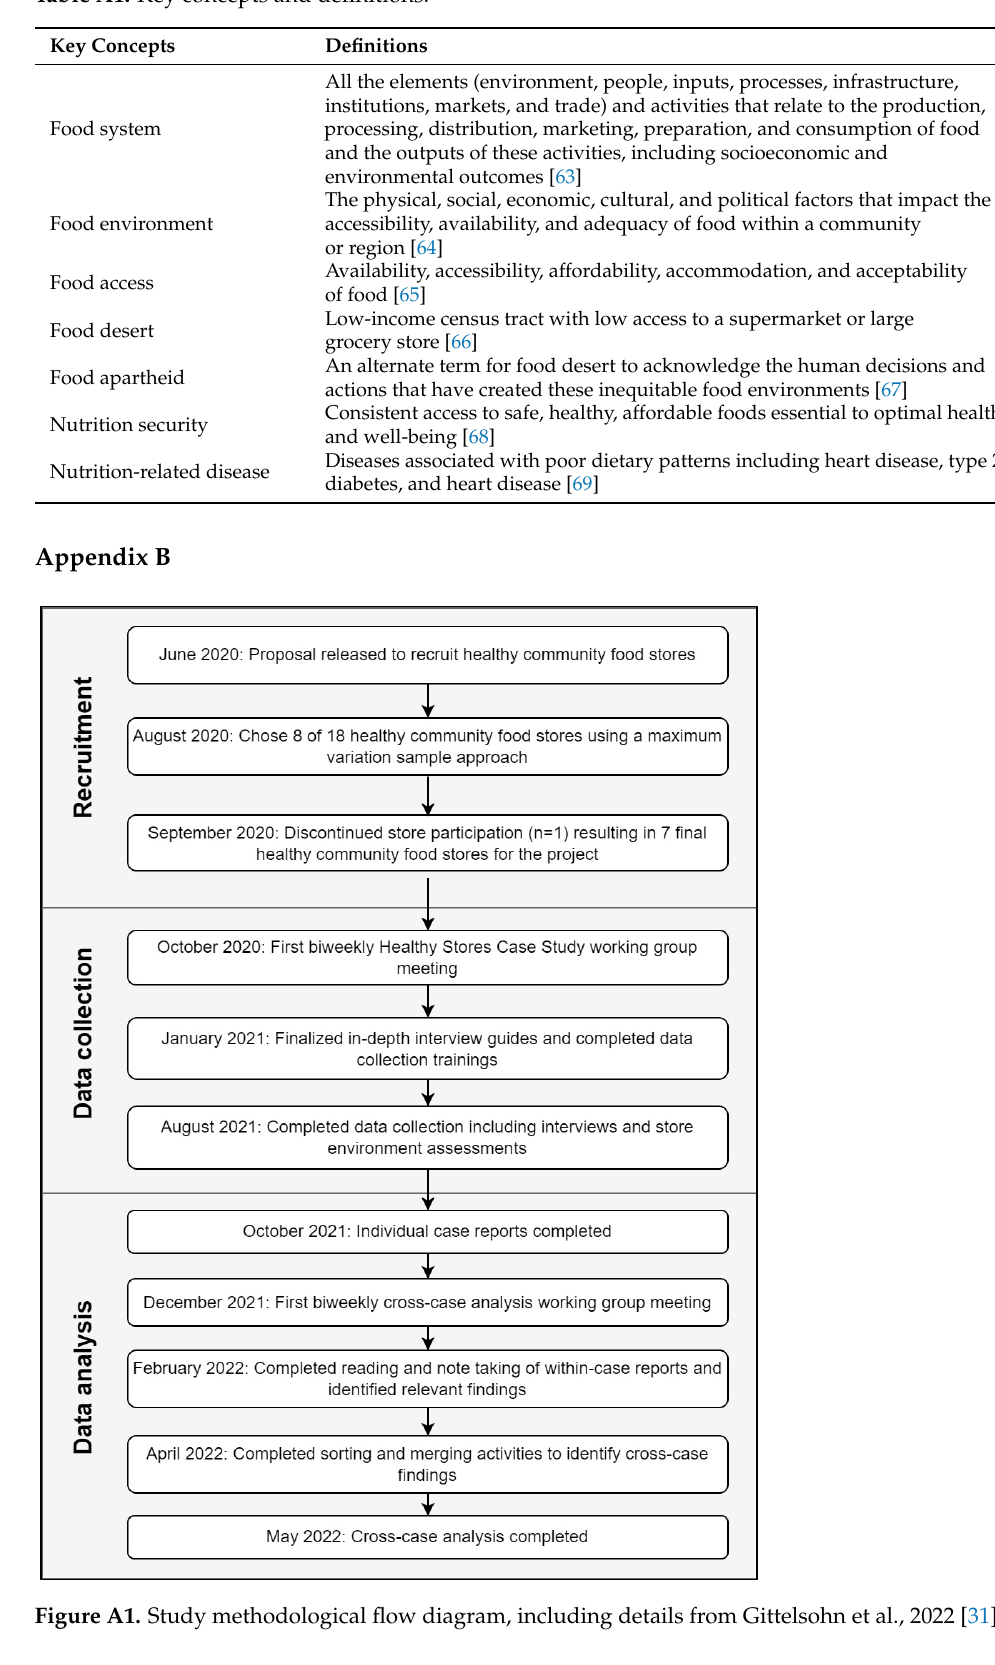
Table A1. Key concepts and definitions.